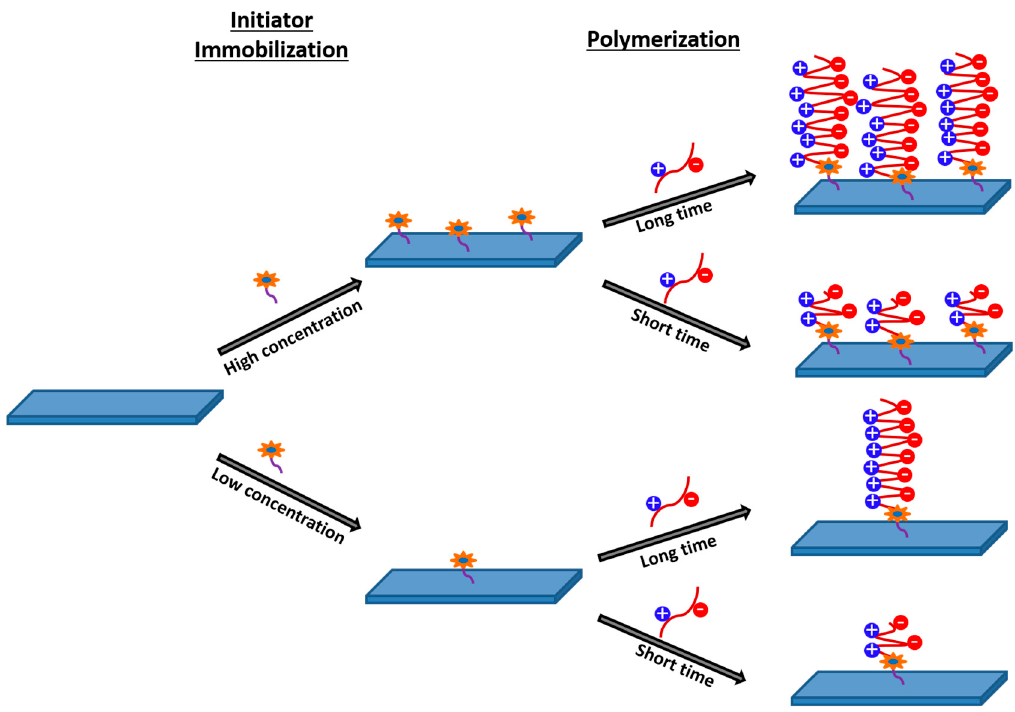
Figure 6. The schematic presentation for ATRP to graft zwitterionic brush. Poly [2 ‐ (methacryloyloxy) ‐ ethyl] dimethyl ‐ (3 ‐ sulfopropyl) ammonium hydroxide (PSBMA) was grafted on a commercial pristine FO membrane. It was found to produce a zwitterionic TFC membrane having enhanced hydrophilicity, reduced surface charge and surface roughness [83]. PSBMA ‐ grafted TFC membrane was reported to have a narrower adhesion force distribution, ca, − 0.07 ± 0.15 mN/m, revealing a 92% reduction compared to virgin membrane. The effective shielding of carboxylic acid groups resulted in the pre ‐ vention of Ca 2+ ‐ induced fouling. Additionally, the swelling of the zwitterionic polymeric chain resulted in a further reduction of the adhesive force because of the increase of dis ‐ tance between the solid ‐ water interface and the membrane surface. The protein adsorp ‐ tion was monitored using a FITC ‐ BSA model by fluorescence spectroscopy. The highly intense fluorescent membrane surface for virgin membrane was attributed to the BSA ad ‐ sorption, which led to almost no fluorescent membrane surface after zwitterionic poly ‐ meric brush grafting. This indicated the antiprotein adsorption characteristics of the mem ‐ brane due to the presence of zwitterions. The zwitterionic modification was claimed to result in an almost 90% reduction in colony forming units (CFUs) against E coli bacteria. Static and dynamic fouling experiments confirmed that the presence of zwitterions on the membrane surface not only improved the hydrophilicity of the surface resulting in an enhancement in membrane permeability, but also extensively improved the antifouling characteristics of the membrane towards inorganic scaling, protein adsorption, and even bacterial/biofilm growth. Zhang et al. [84] investigated different cleaning approaches for FO membranes hav ‐ ing zwitterionic poly ‐ (sulfobetaine methacrylate) brushes prepared by ATRP subjected to crude oil and anionic polyacrylamide as model fouling solution for treatment of polymer flooding ‐ produced water. They reported a significant enhancement in irreversible fouling with increasing relative concentration of crude oil in the feed solution. Five different clean ‐ ing protocols have been adopted as follows: (1) Simple hydraulic washing: Feed: DI water; Draw solution: DI water; pH 7 (2) Osmotic backwashing: Feed: 2 M NaCl, Draw solution: DI water; pH 7